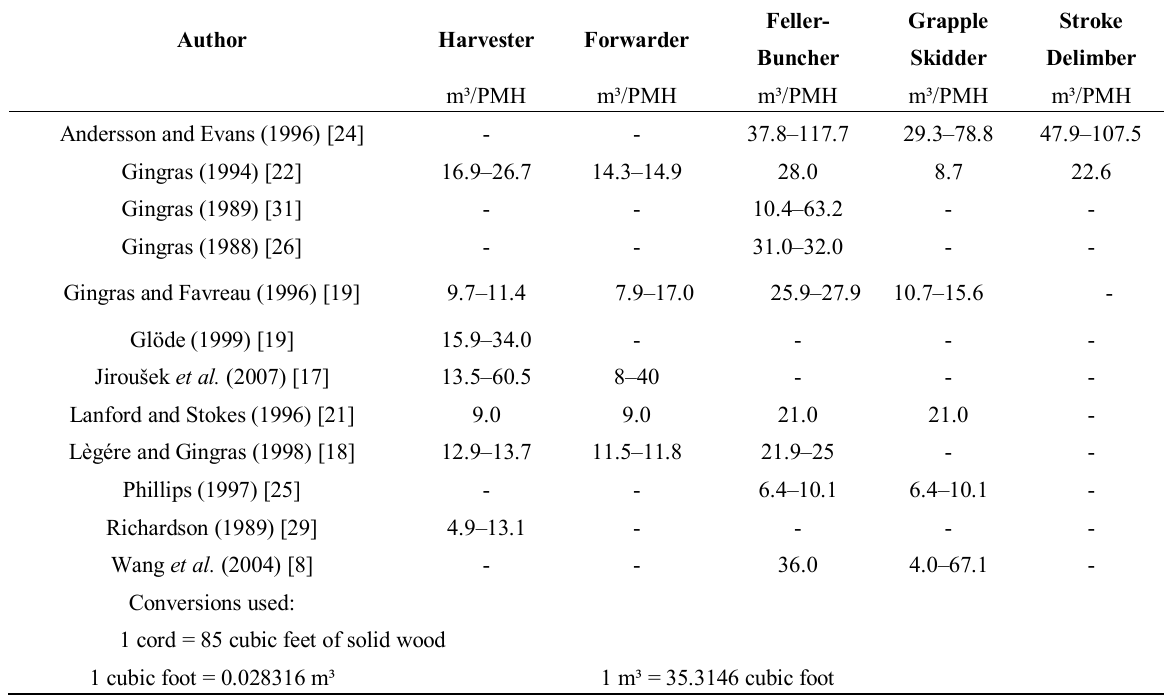
Table 2. Summary of productivity results from previous timber harvesting